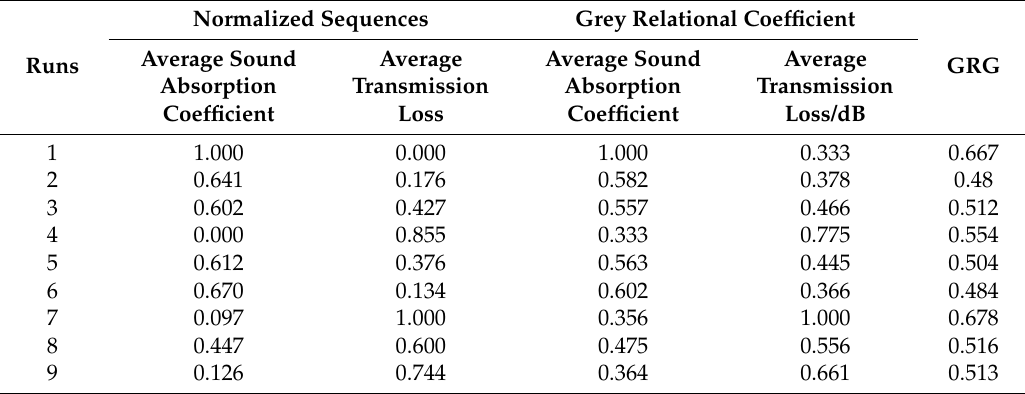
Table 4. Calculation results of normalized sequences, grey relational coefficient and grey relational grade